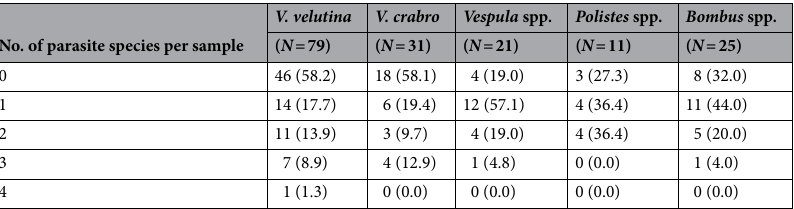
Table 2. Co-occurrence of parasites in samples across hosts. Number of samples with different number of parasite species. Relative frequencies (%) are given in